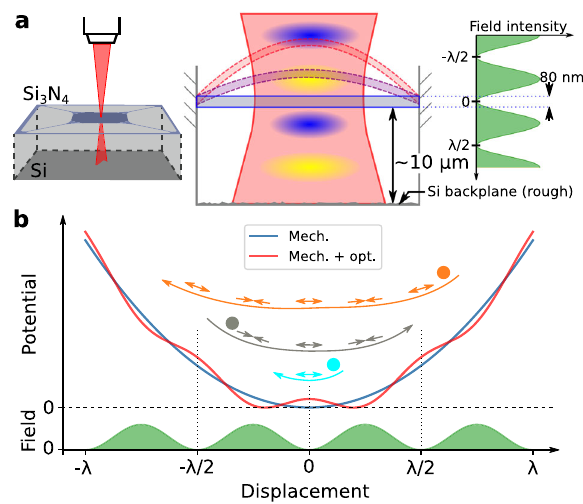
Fig. 1 | Schematic of overtone frequency comb. a The suspended Si 3 N 4 mem- brane is subject to an out-of-plane laser, focused through a microscope objective. Part of the light is re fl ected from the Si backplane and interferes with the incident light, creating a counterpropagating-wave optical trap such that the fi eld intensity (green) is periodic. The membrane is clamped to the substrate, and motion is predominantly out-of-plane (purple, red dashed lines). b The optical fi eldintensity causes a (spatially) periodic modulation of the elastic potential through the die- lectrophoretic force (red, blue lines). For the small motion of a membrane at fre- quency ω 0 (cyan), the restoring force component from the optical fi eld switches sign twice per oscillation (arrow pairs), the same as the elastic potential. However, for larger membrane motion (gray, orange), more optical extrema are crossed so the optical fi eld component switches signmultiple times per oscillation, ef fi ciently generating frequency components at n ω 0 ( n =2,3,4, … ) which form an overtone frequency